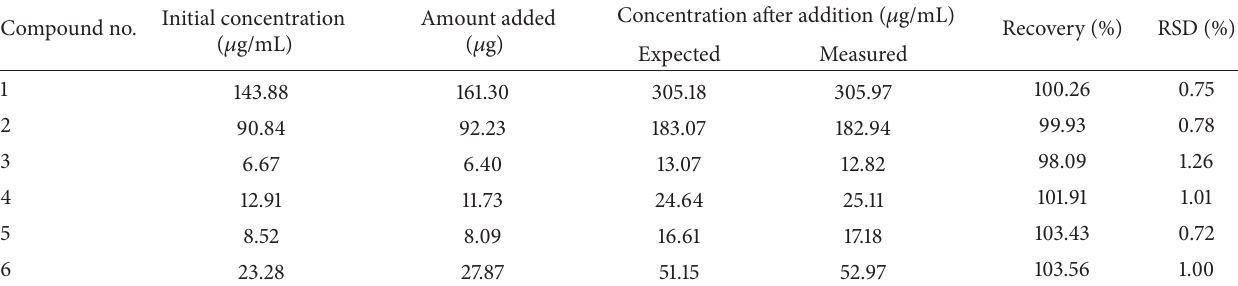
Table 3: Recovery of each compound as determined by standard addition method (in rhizome) ( 𝑛 = 6 ). Initial concentration Compound no. ( 𝜇